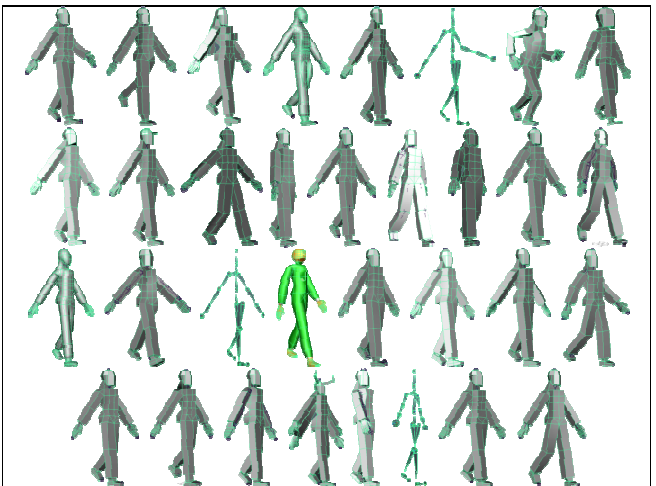
Figure 8. Attaching the Body Parts (see text for